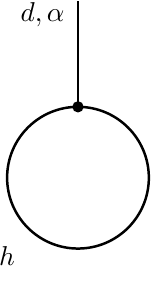
Figure 5 . Torus 1-point conformal